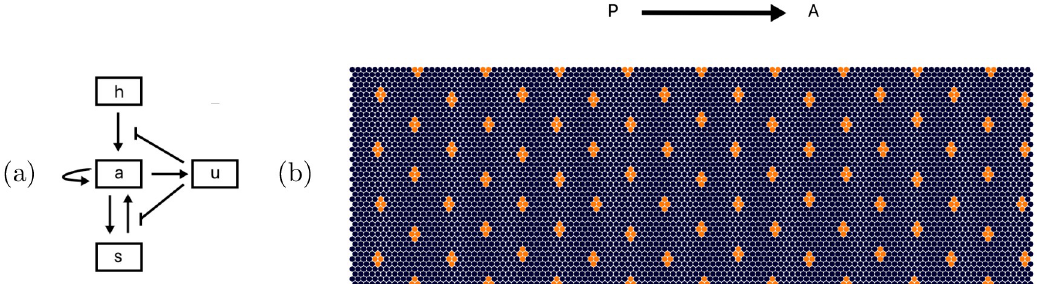
Fig 3. Interactions between morphogens and the simulation of the R8 cell ordered pattern. a) In this diagram we show the interactions defining the regulatory network between the four morphogens in the mathematical model. h acts solely as an activator to a, a increases production of itself and leads to production of u and s , s activates a and lastly, u inhibits the effect of h and s . b) Ordered R8 cell pattern obtained by the mathematical model. The pattern was obtained numerically using the parameters used in [7] (shown in S1